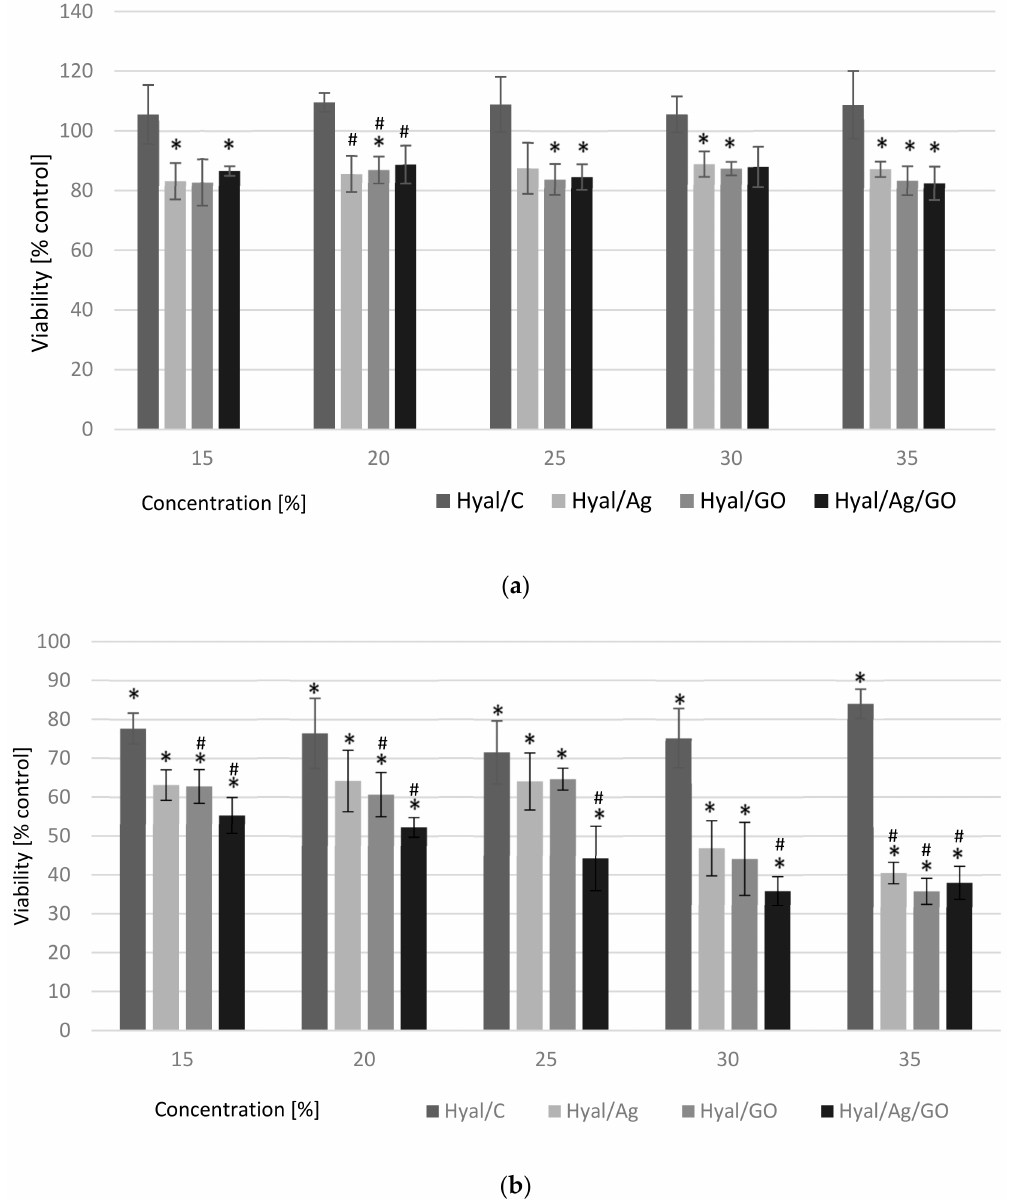
Figure 5. Effect of nanoparticle composites on WM-266-4 cells viability. WM-266-4 melanoma was seeded on the 96-well plates (8 × 103 cells per well). Twenty-four hours after seeding, the growth medium was replaced with a medium containing nanoparticle composites for ( a ) 24 h and ( b ) 48 h. Values are expressed as mean ± SD for n = 12, standardized to untreated control (UC) as 100%. Statistical significance was based on t-test * p ≤ 0.05 vs. UC and # p ≤ 0.05 vs. sodium